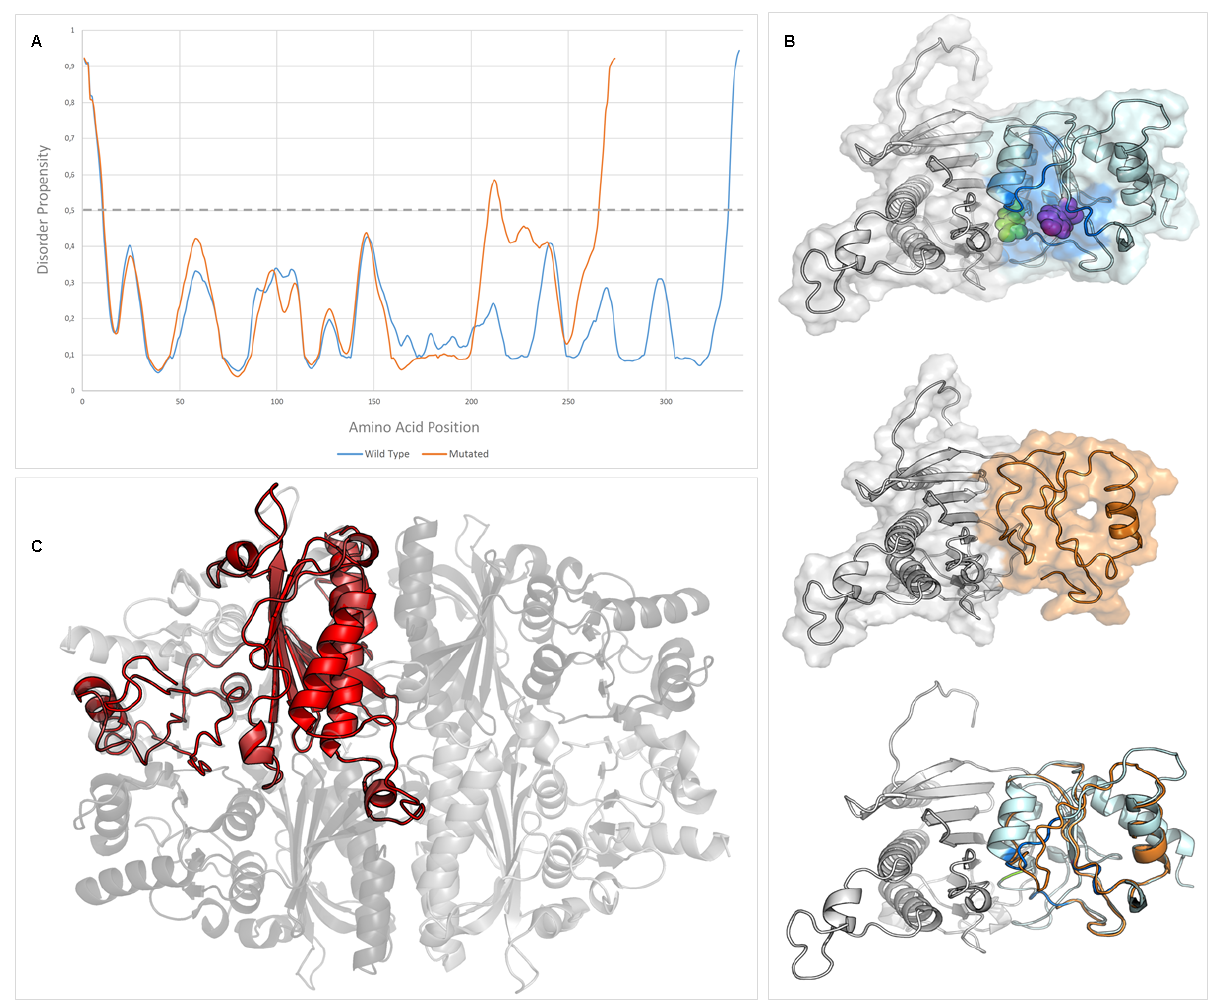
Figure 2 – In silico analysis of the NP_000498.2:p.(Lys204ArgfsTer32) variant in the FBP1 gene. A) Disorder prediction for wild-type (blue line) and mutated (orange line) FBPases. B) 3D modeling of fructose-1,6-bisphosphatase. First image, the wild-type FBPase. The region affected in the mutant protein is shown in light blue, the altered substrate binding regions are shown in dark blue, the altered substrate recognition site is shown in magenta, and the altered Mg binding site is shown in green. Right below, the mutant FBPase. The region affected by the frameshift mutation is shown in orange. All sites highlighted in WT are absent in the mutant protein. Lastly, the superposition of WT and mutant FBPase, colored according to the previous. C) The structure of fructose-1,6-bisphosphatase tetramer. Superposition of mutant FBPase monomer (red) onto the functional FBPase tetramer (in different shades of gray). Note the absence of structured elements in the exposed region of the monomer. Tetramer information from PDB ID 2FIE (Lai et al .,